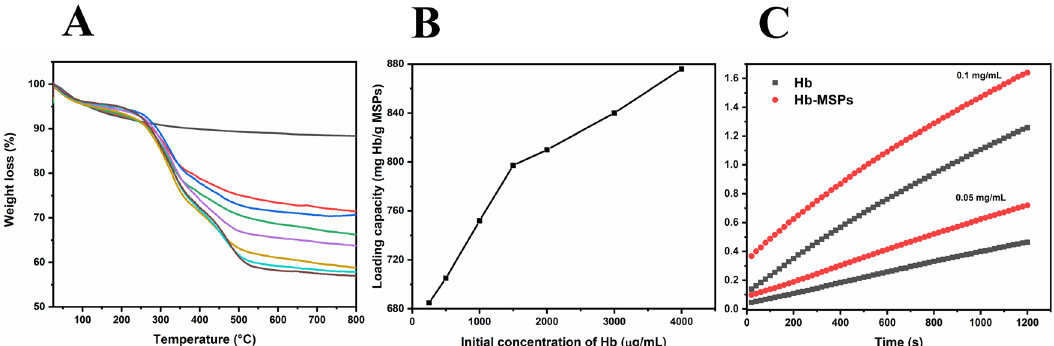
Figure 3. ( A ) Thermogravimetric analysis curves of Hb-loaded MSPs with different initial Hb concentrations (0, 0.25, 0.5, 1, 1.5, 2, 3, 4 mg/mL; top to bottom). ( B ) Corresponding loading capacities of Hb into MSPs calculated by thermogravimetric analysis. ( C ) ABTS catalyzed by native Hb and Hb-loaded MSPs. The enzymatic activity of Hb was measured at 418 nm as the catalytic conversion of oxidation of ABTS.